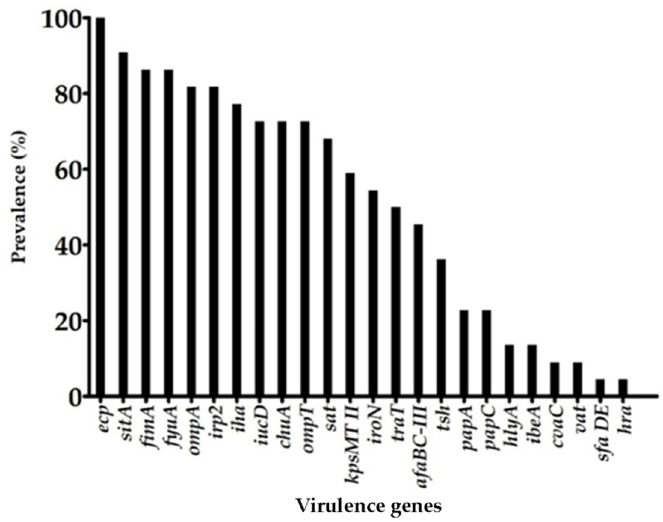
Figure 1. Virulence genes prevalence among Escherichia coli strains isolated from eye infections. The aggR, afaE-VIII, bfpB, bmaE, cf29A, cnf1, eae, eltA, escV, estA, invE, ireA, kpsMTIII, stx-1, and stx-2 genes were absent in all strains.